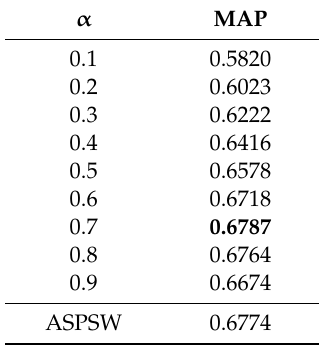
Table 3. The prediction accuracy of di ff erent α ; the best result is in bold-face.